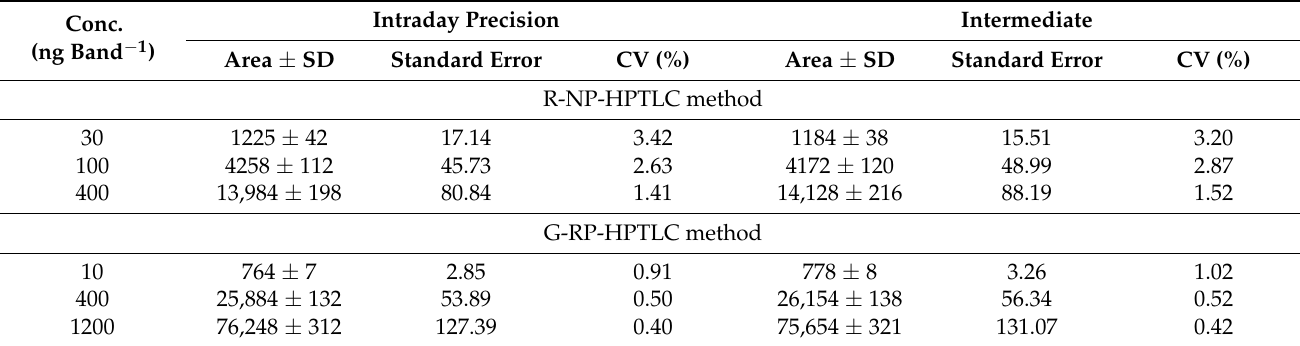
Table 4. For the determination of instrumental variation, a single band (MCQ) for RP/NP densitometric assay was analyzed several times and % CV was calculated. The % CV for the ecologically greener RP and routine NP densitometric assay were determined as 0.46 and 2.37 %, respectively. The % CVs of TRV for the ecologically greener RP densitometric assay